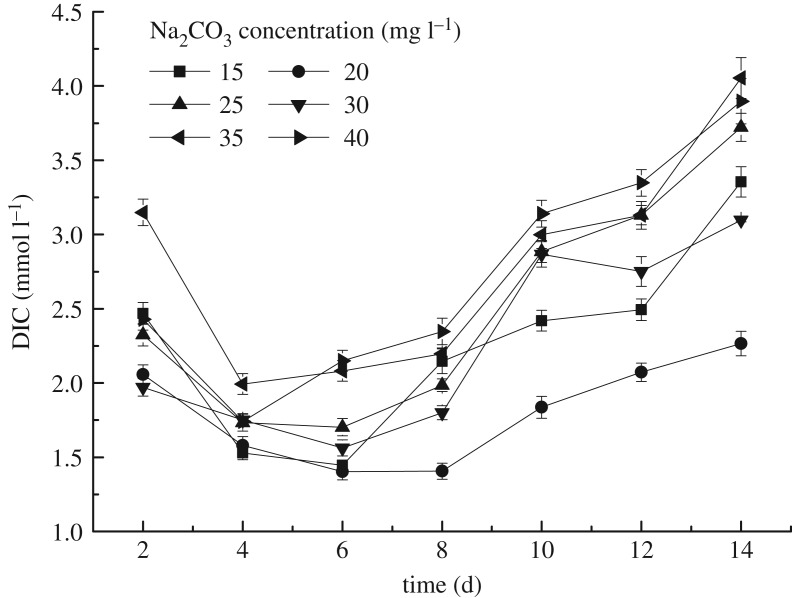
The DIC concentration changes of the microalgae liquid under the different Na2CO3 concentrations.